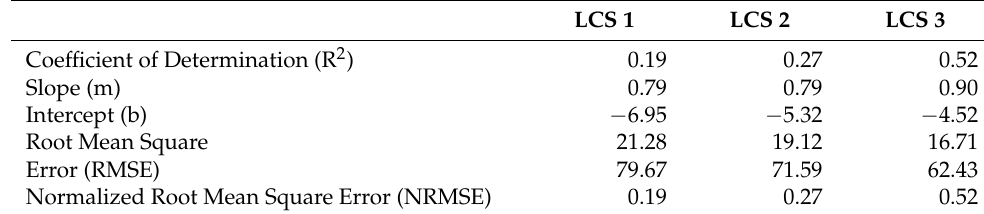
Table 1. Accuracy of LCS (PM10) following